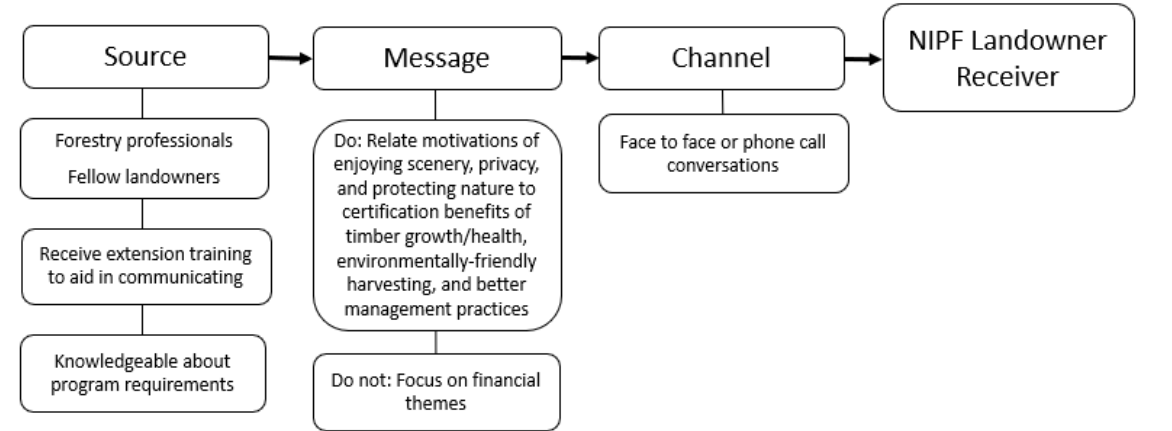
Figure 2. Applying Berlo’s (1960) SMCR model to NIPF landowner preferences.